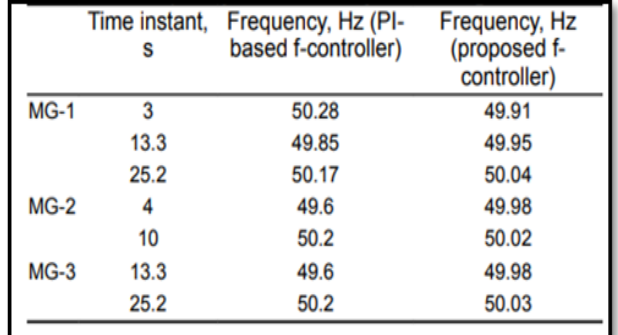
Table 1. Frequency in the MMG system during